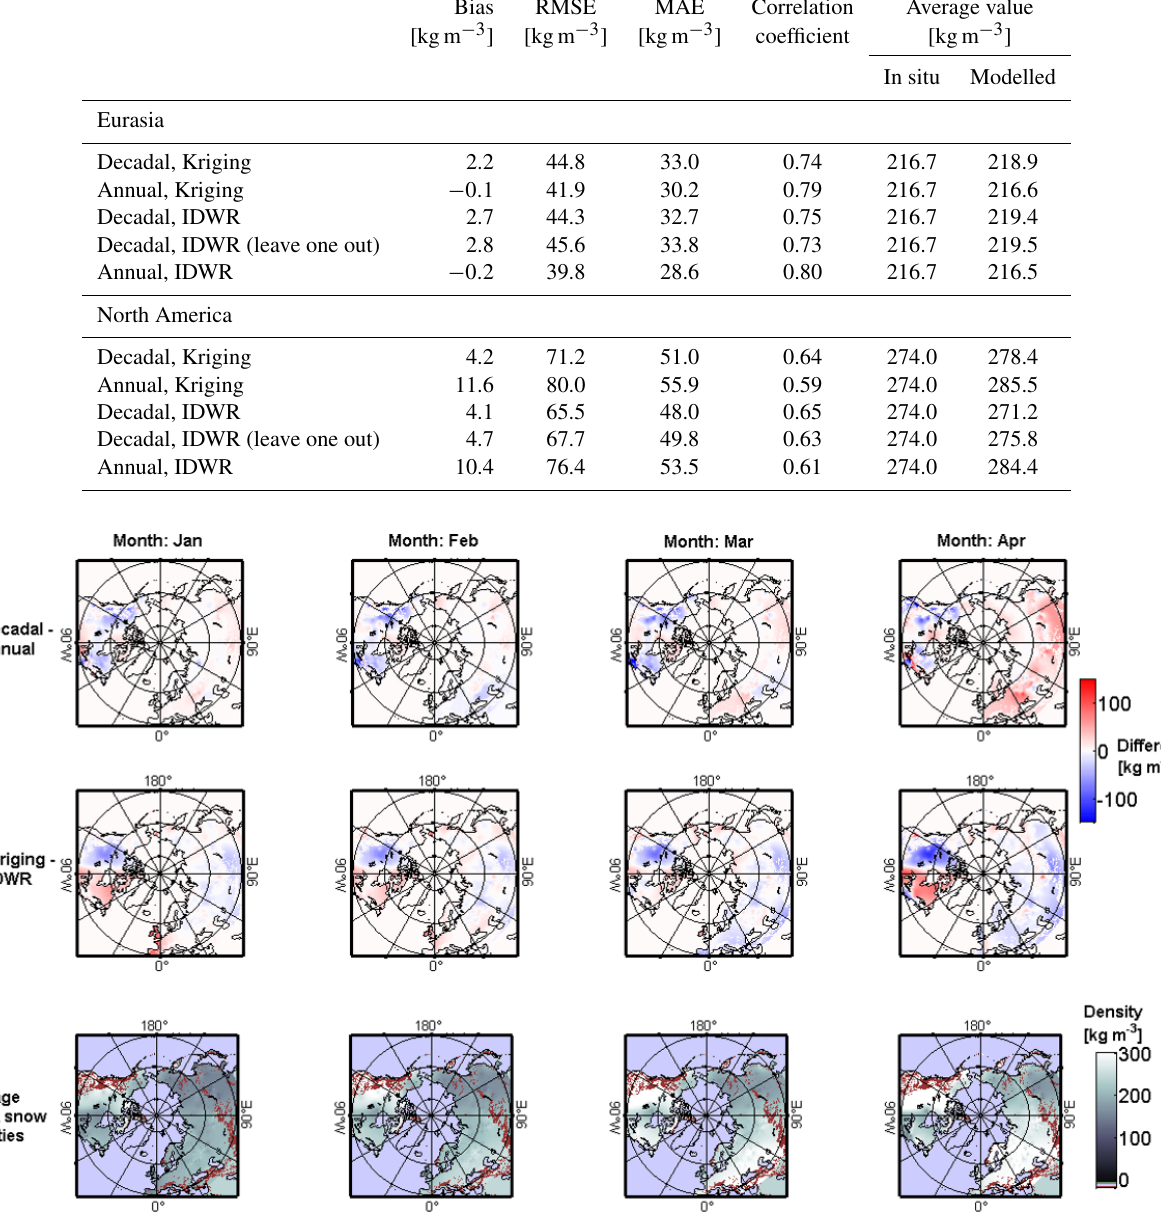
Figure 4. Top row shows monthly difference between average snow density values of decadal and annual (Kriging) densities. Middle row shows average differences between Kriging and IDWR (annual) densities. Bottom row shows average IDWR densities. Differences and densities are shown for January, February, March, and